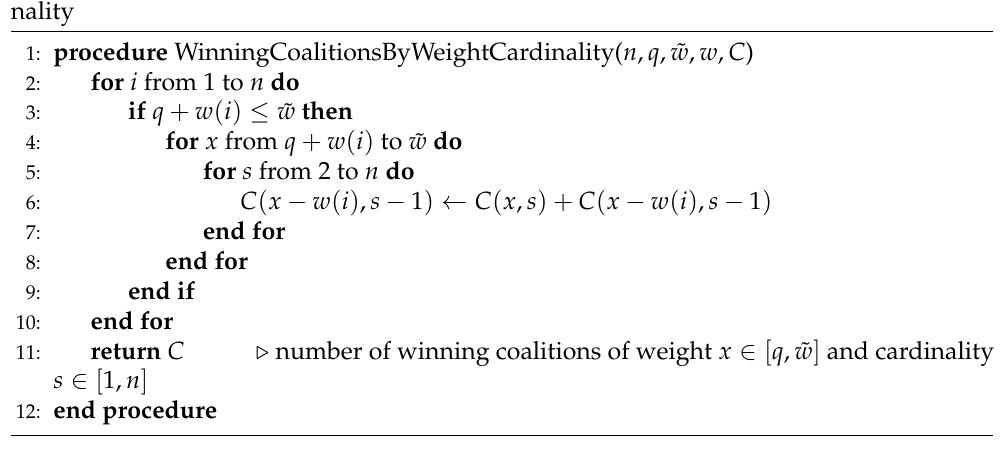
Algorithm 3 Generalized counting of number of winning coalitions per weight and